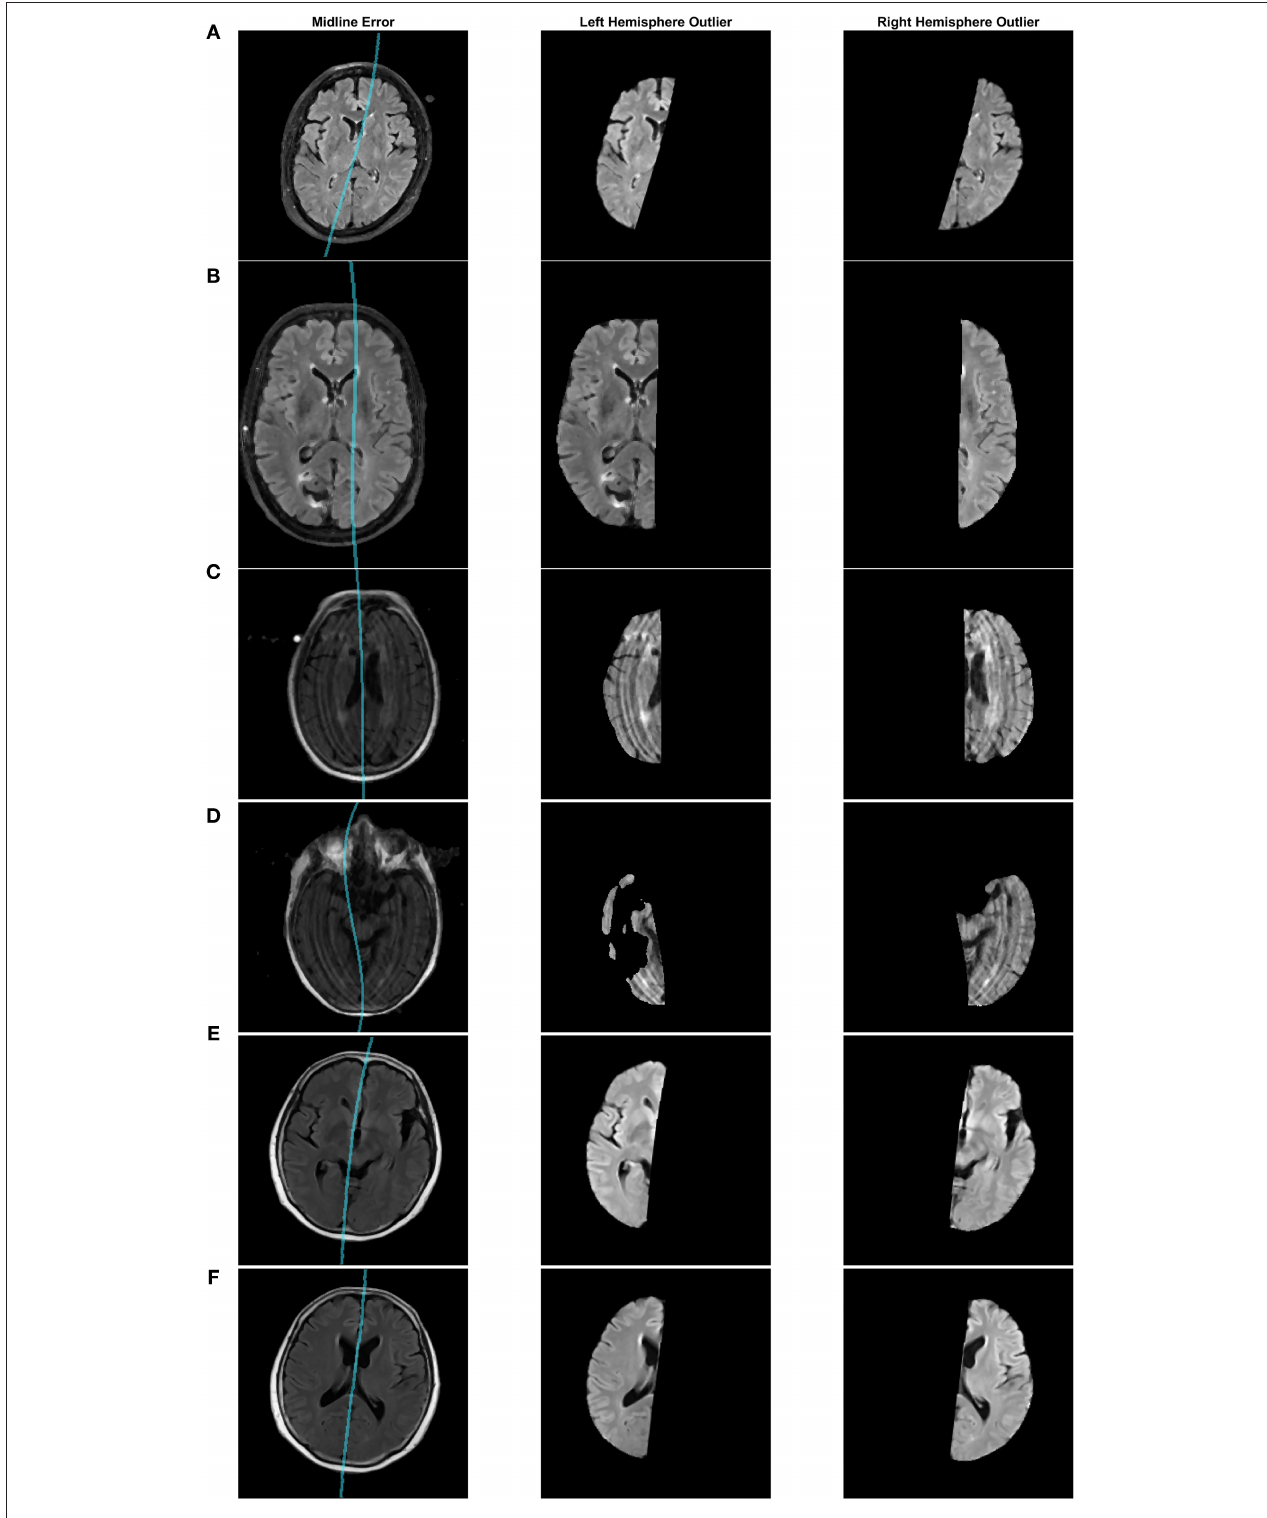
FIGURE 8 | Midline estimation errors detected using the asymmetry index outlier detection method. Cases from (A–F) : CCNA, CAIN, ADNI, ADNI, ADNI, ADNI.